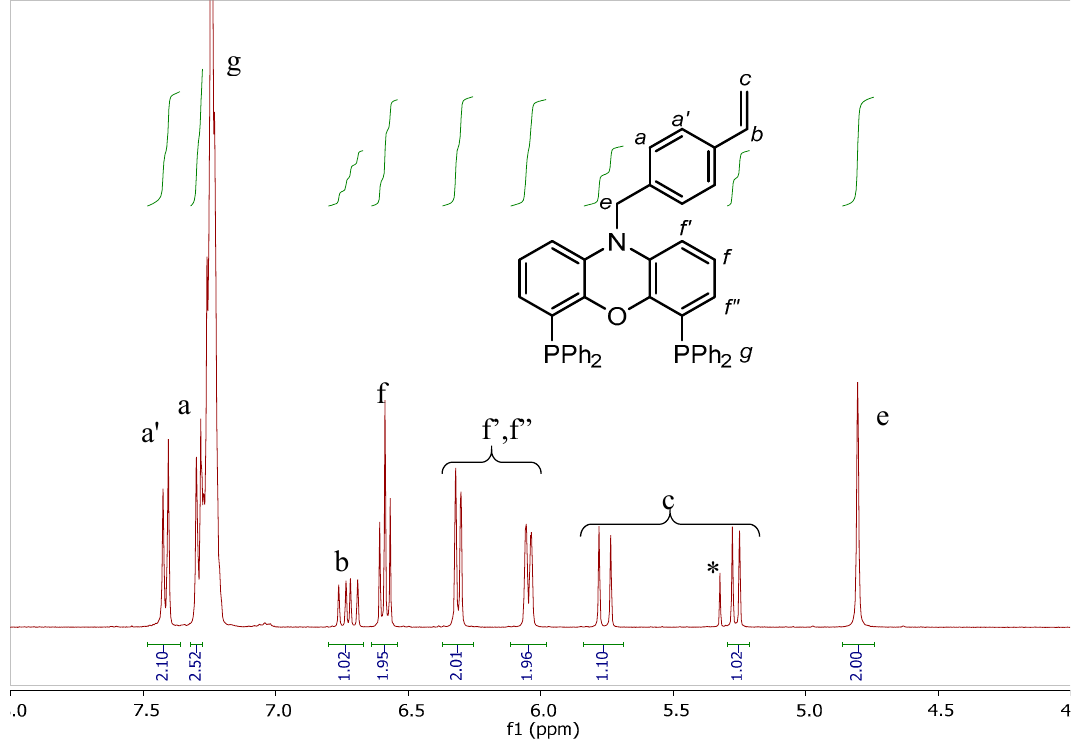
Figure 1. 1 H NMR of compound 1 in CDCl 3 . The starred resonance belongs to residual CH 2 Cl 2 .